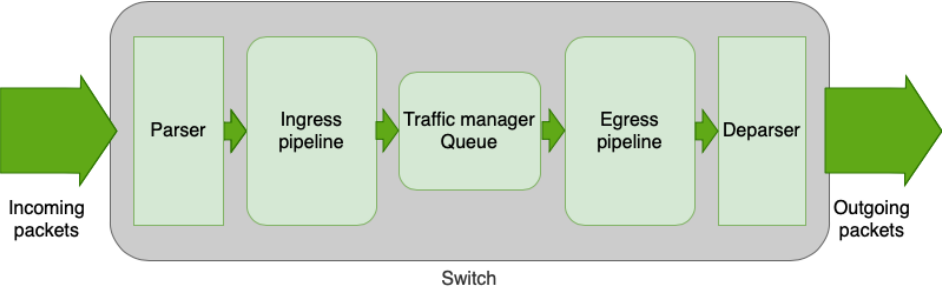
Figure 3. Architecture of a P4